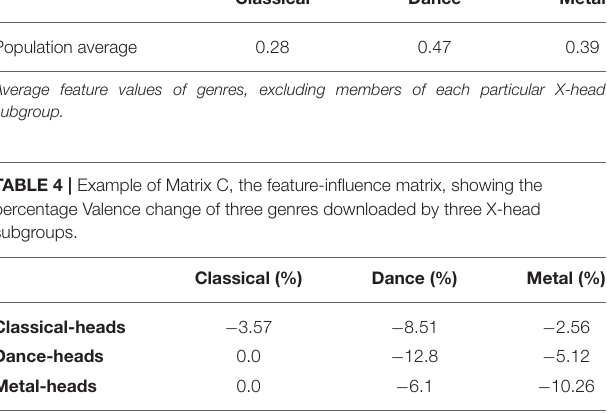
TABLE 3 | Example of Submatrix B for feature Valence with three genres. Classical Dance Metal Population average 0.28 Average feature values of genres, excluding members of each particular X-head subgroup.